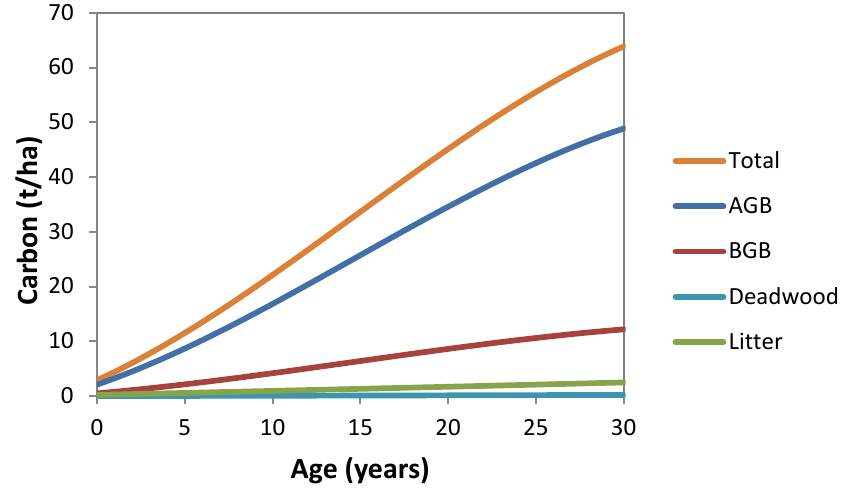
Figure 4. Estimated carbon stocks in relation to age for post-1989 natural forest (with one outlier plot excluded) across all pools and for individual pools: AGB, BGB, deadwood and